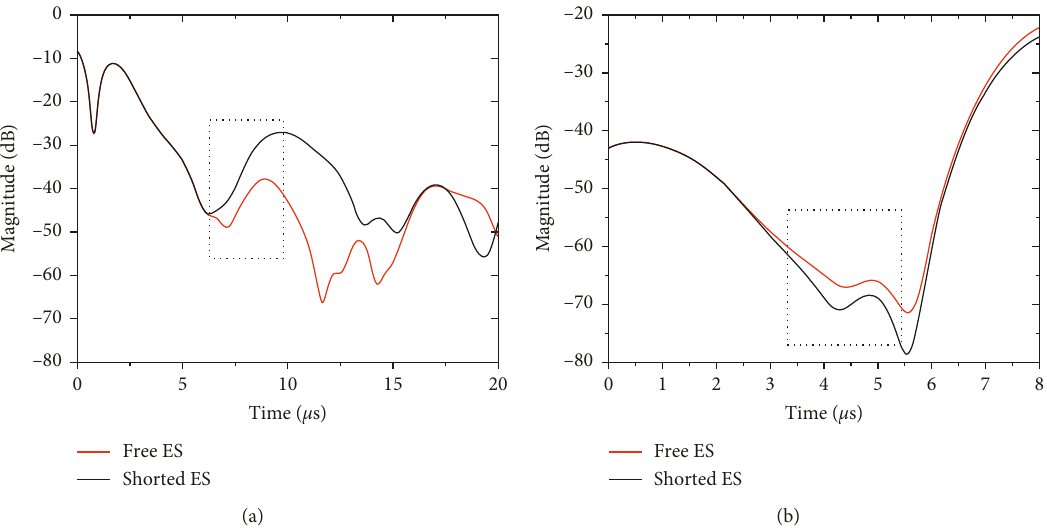
Figure 10: Measured time response for the (a) reflected and (b) transmitted signals. The red and black curves correspond to the free and shorted conditions of the IDT. The dotted rectangular shows the induced structure time